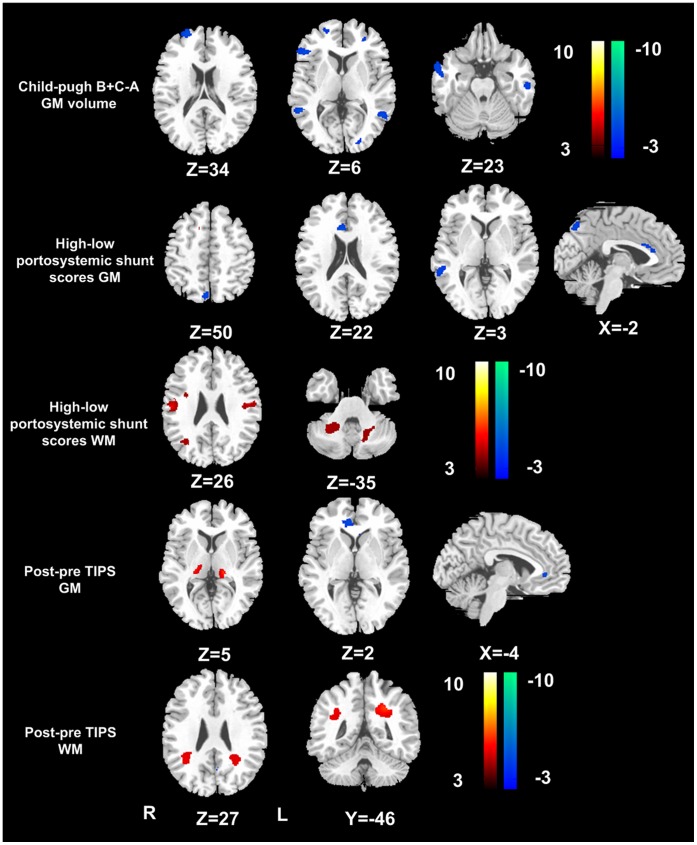
Brain volume changes with Child-Pugh scale and portosystemic shunt.Compared with patients with Child-Pugh A, patients with Child-Pugh B plus C showed decreased gray volume in the frontal, parietal and temporal cortex (Panel at Line 1). Patients with high portosystemic shunt scores (≥4) displayed decreased gray matter volume in the anterior cingulate cortex (ACC) and precuneus, and increased white matter volume in the parietal lobe, internal capsule, and cerebellum crus, when comparing to those with low portosystemic shunt scores (Panels at lines 2 and 3). Compared with pre-TIPS, post-TIPS patients displayed decreased gray matter volume in the ACC, cerebellar vermis, increased gray matter volume in the thalamus, and increased white matter volume in bilateral posterior periventricular white matter (Panels at lines 4 and 5). (P<0.01, FDR corrected). GM = gray matter; WM = white matter; TIPS = transjugular intrahepatic systemic shunt; R = right; L = left.